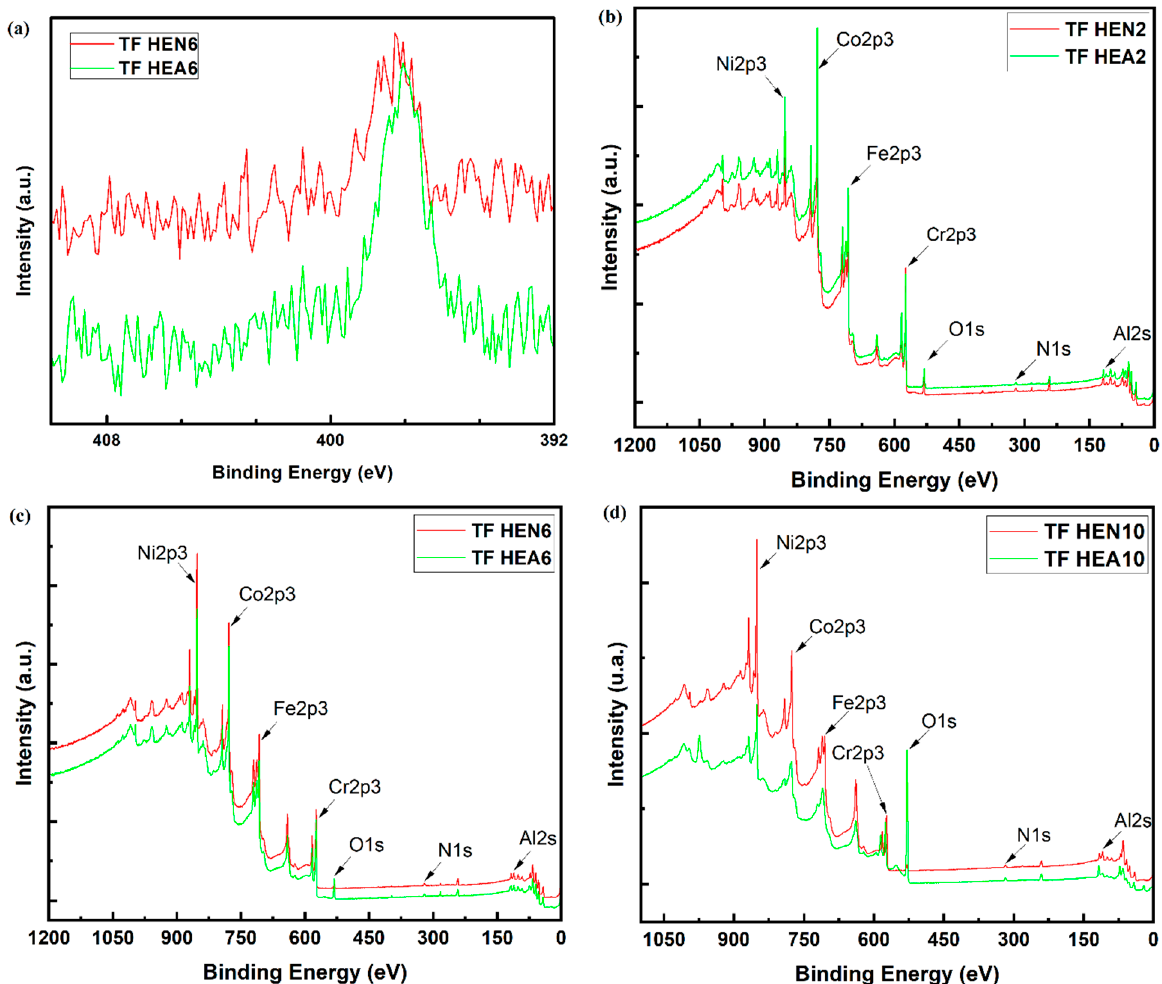
Figure 8. Plotted data on chemical elemental composition measurements by XPS of ( a ) N 2 content of the thin HEA and HEN films with nickel concentration 1.2, ( b ) overall analysis of the thin HEA and HEN films with nickel concentration 0.4, ( c ) overall analysis of the thin HEA and HEN films with nickel concentration 1.2, and ( d ) overall analysis of the thin HEA and HEN films with nickel concentration 1.8.